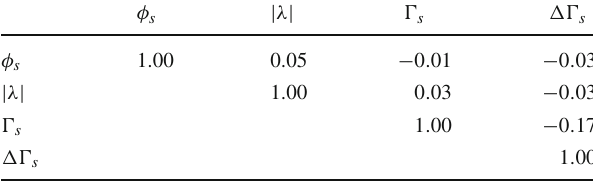
Table 7 Correlation matrix for the results in Eq. (17) obtained taking into account correlated systematics between the considered analyses